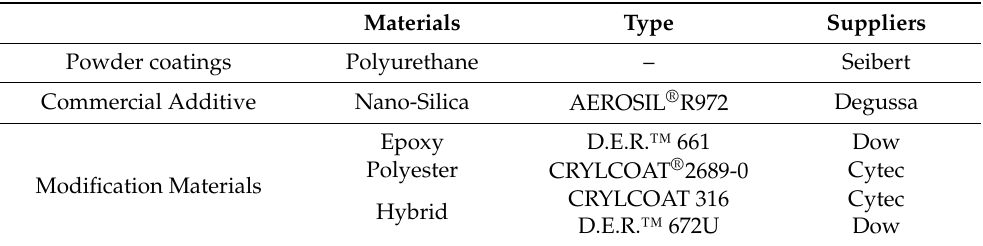
Table 1. List of materials used in this study.